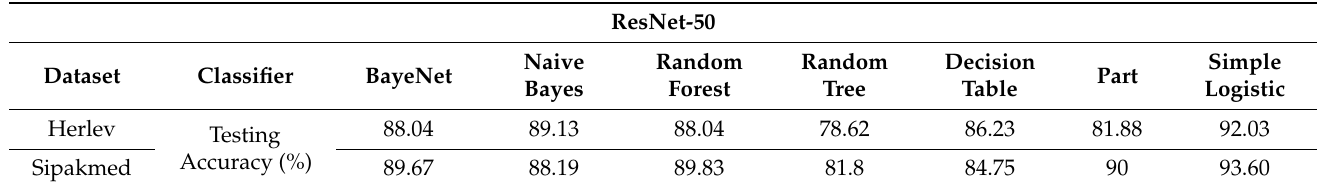
Table 9. Classification accuracy of ResNet-50 model with machine learning classifiers.